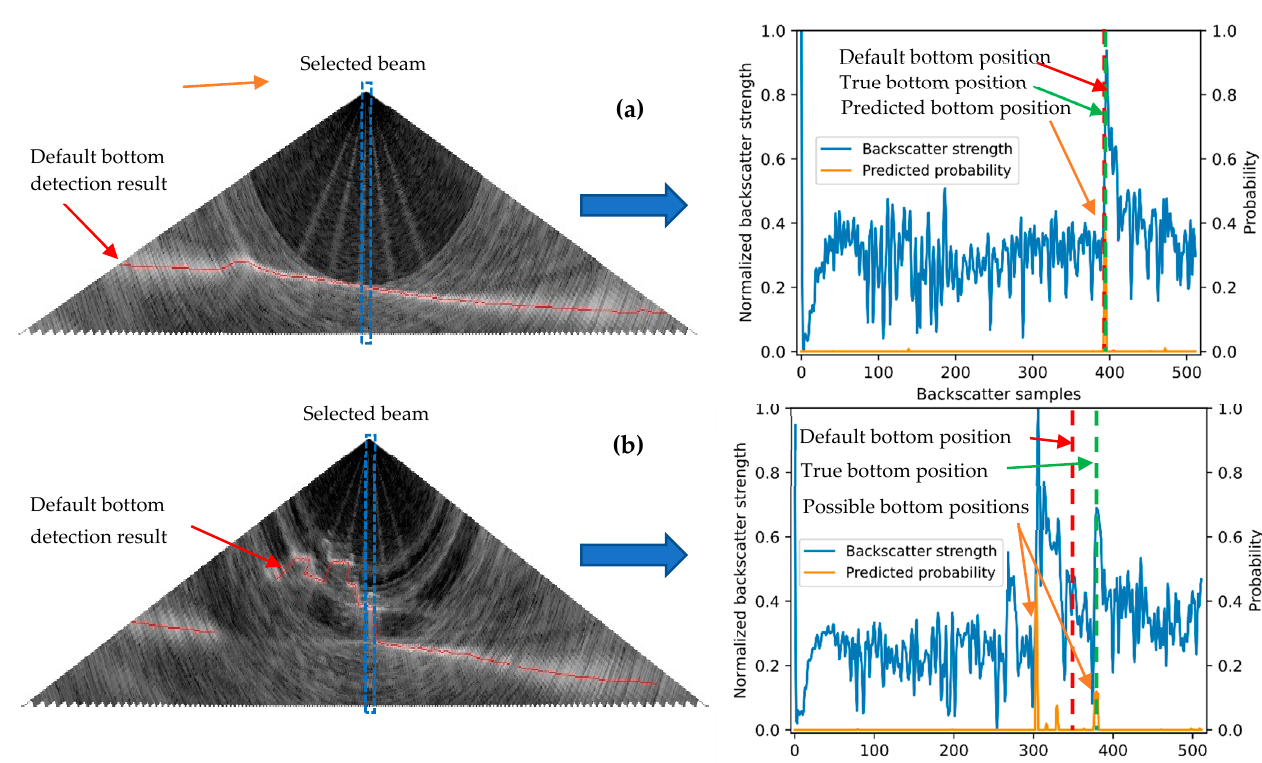
Figure 17. Apply the 1D-UNet model for bottom detection from backscatter data of multibeam echosounders. ( a , b ) show two multibeam pings containing water column backscatter data. The backscatter strengths of selected beams in blue rectangles are processed using 1D-UNet, and the corresponding bottom detection results are obtained at the right.